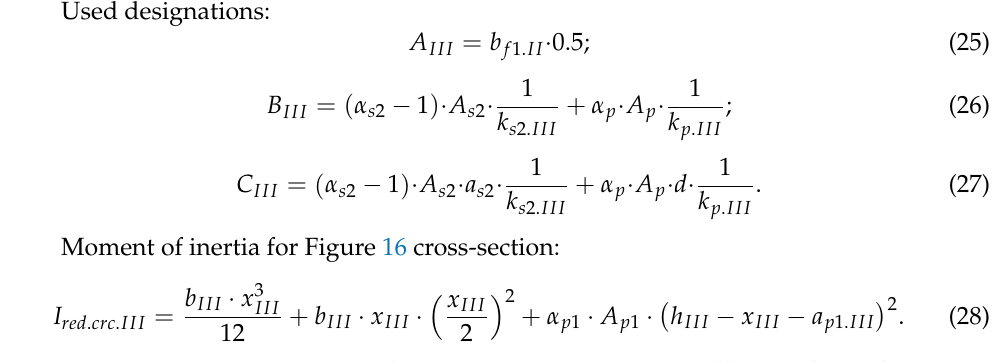
Figure 16. Cracked cross-section III-III.